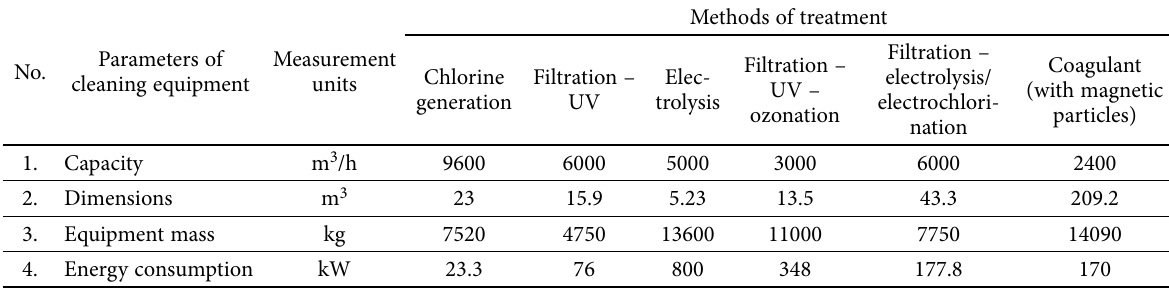
Table 2. Ballast water treatment methods and equipment and their maximum values of indicators